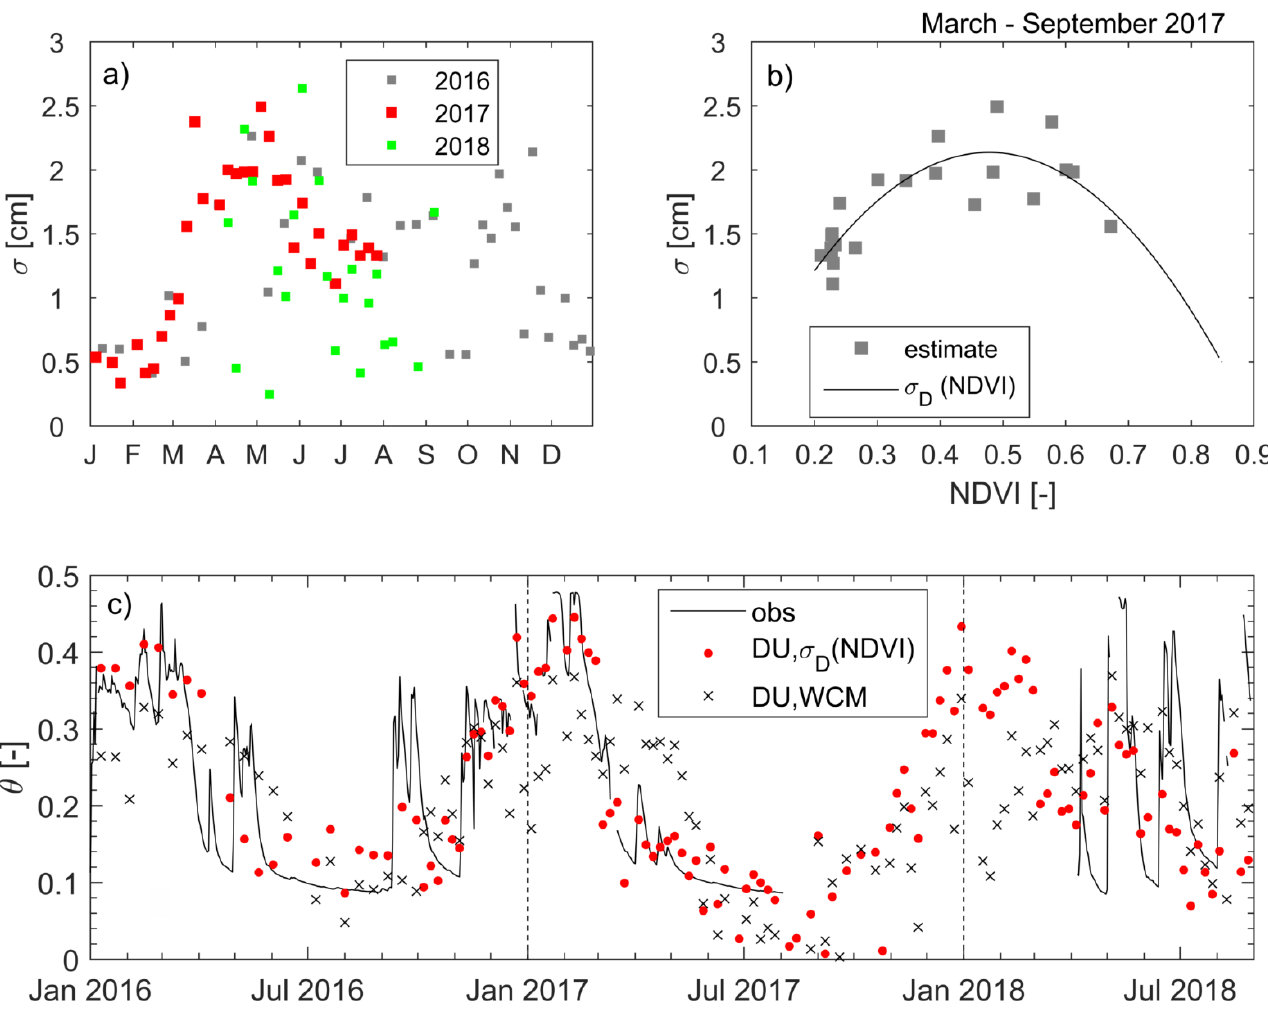
Figure 4. The results using the DU method at the grass field for the 2016–2018 period of: ( a ) estimated roughness length ( σ ) time series for the three years; ( b ) estimated σ versus corresponding NDVI, and fitted line of equation: σ D = − 11.96 NDVI 2 + 11.44 NDVI − 0.5982; ( c ) comparison of soil moisture observed at the Orroli field site (obs), and soil moisture estimated using DU with the WCM (DU, WCM) (with σ = 2 cm), and soil moisture estimated using DU and the proposed σ D (NDVI) relationship (DU, σ D (NDVI)).